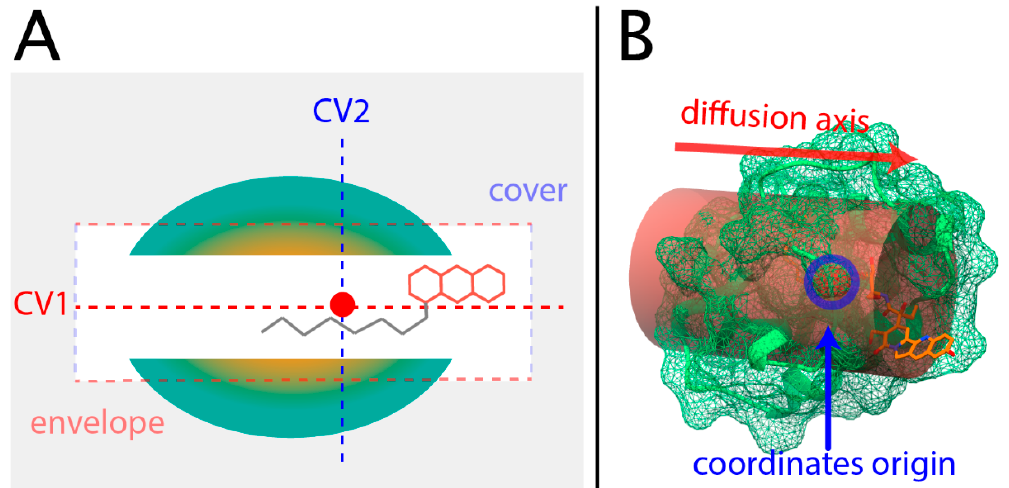
Figure 3. ( A ) Scheme of the collective variables (CVs) setup. ( B ) Rendering of the volume in which the Figure 3. A ) Scheme of the collective variables (CVs) setup. B ) Rendering of the volume in which the ligand tail is confined using harmonic walls (see the text in Section ligand tail is confined using harmonic walls (see the text in subsection 2.3).